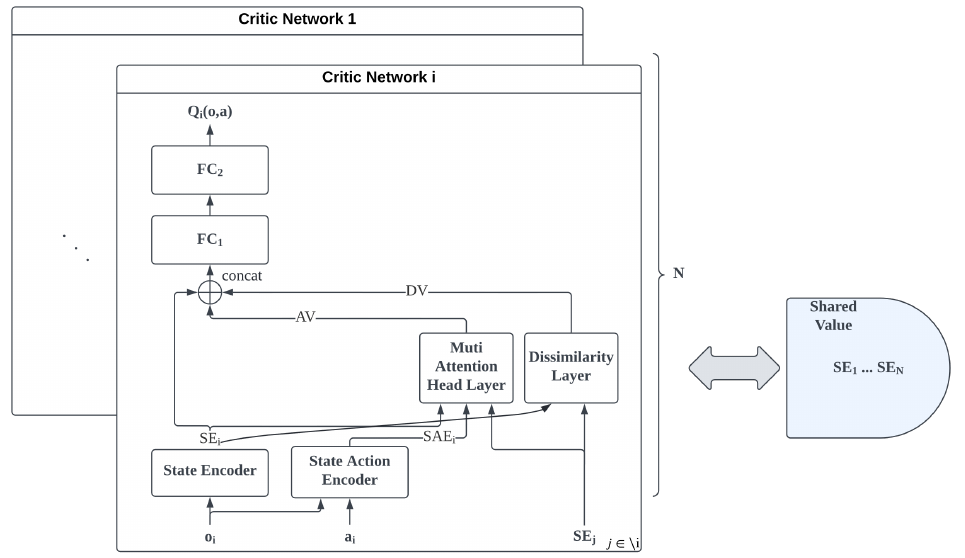
Figure 6. Critic network of F-MAAC